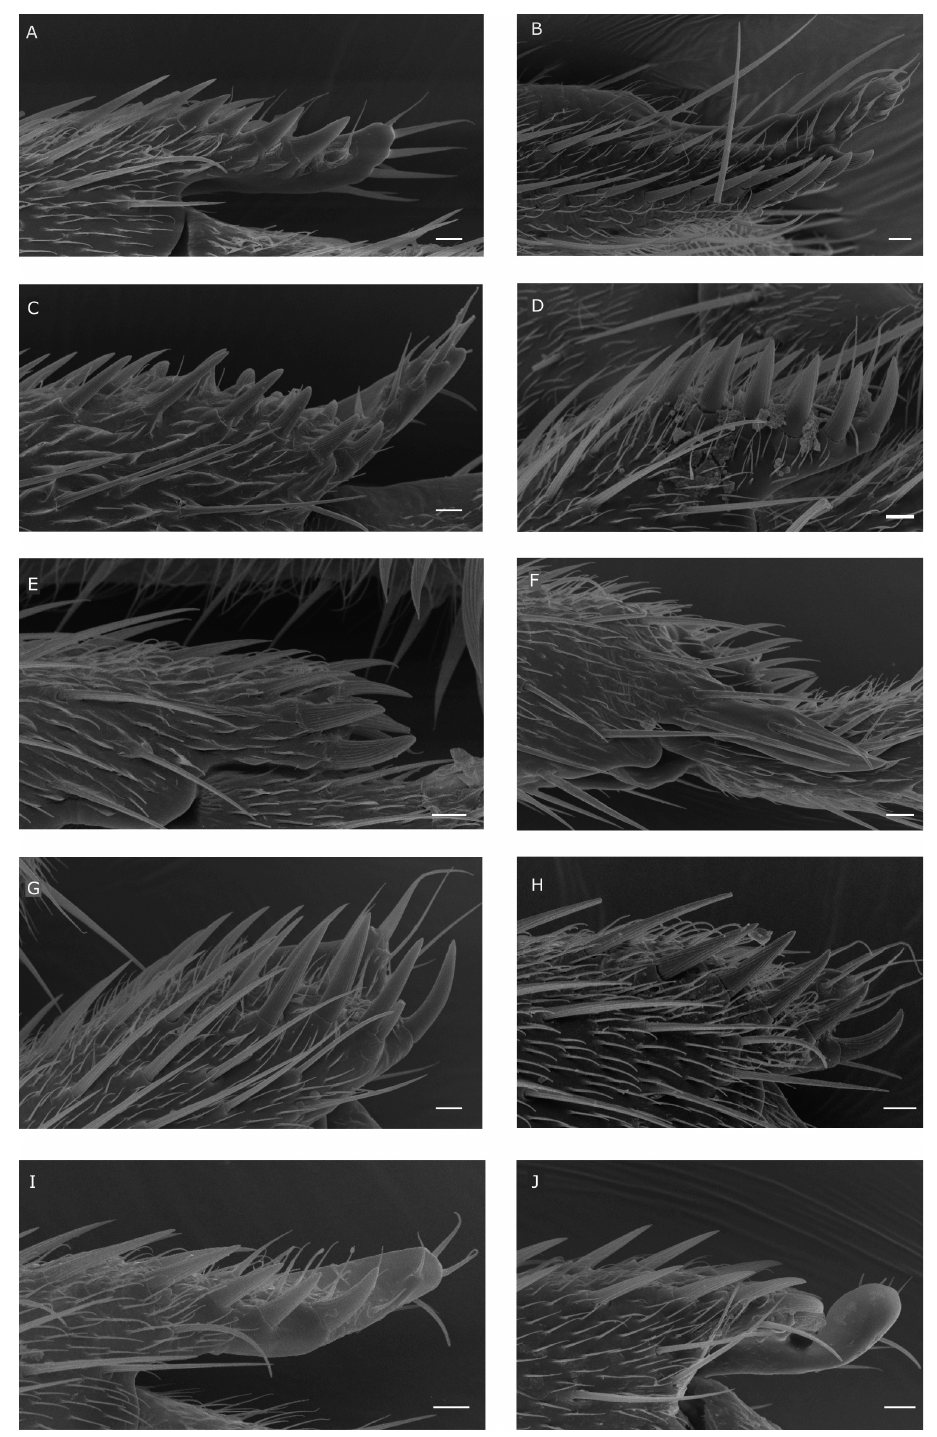
Fig. 19. Images obtained by scanning electron microscopy of the spur-like structures present on the apical portion of the male mid tibia. A . T. lusitanica (Grootaert, Shamshev & Andrade, 2009). B . T.